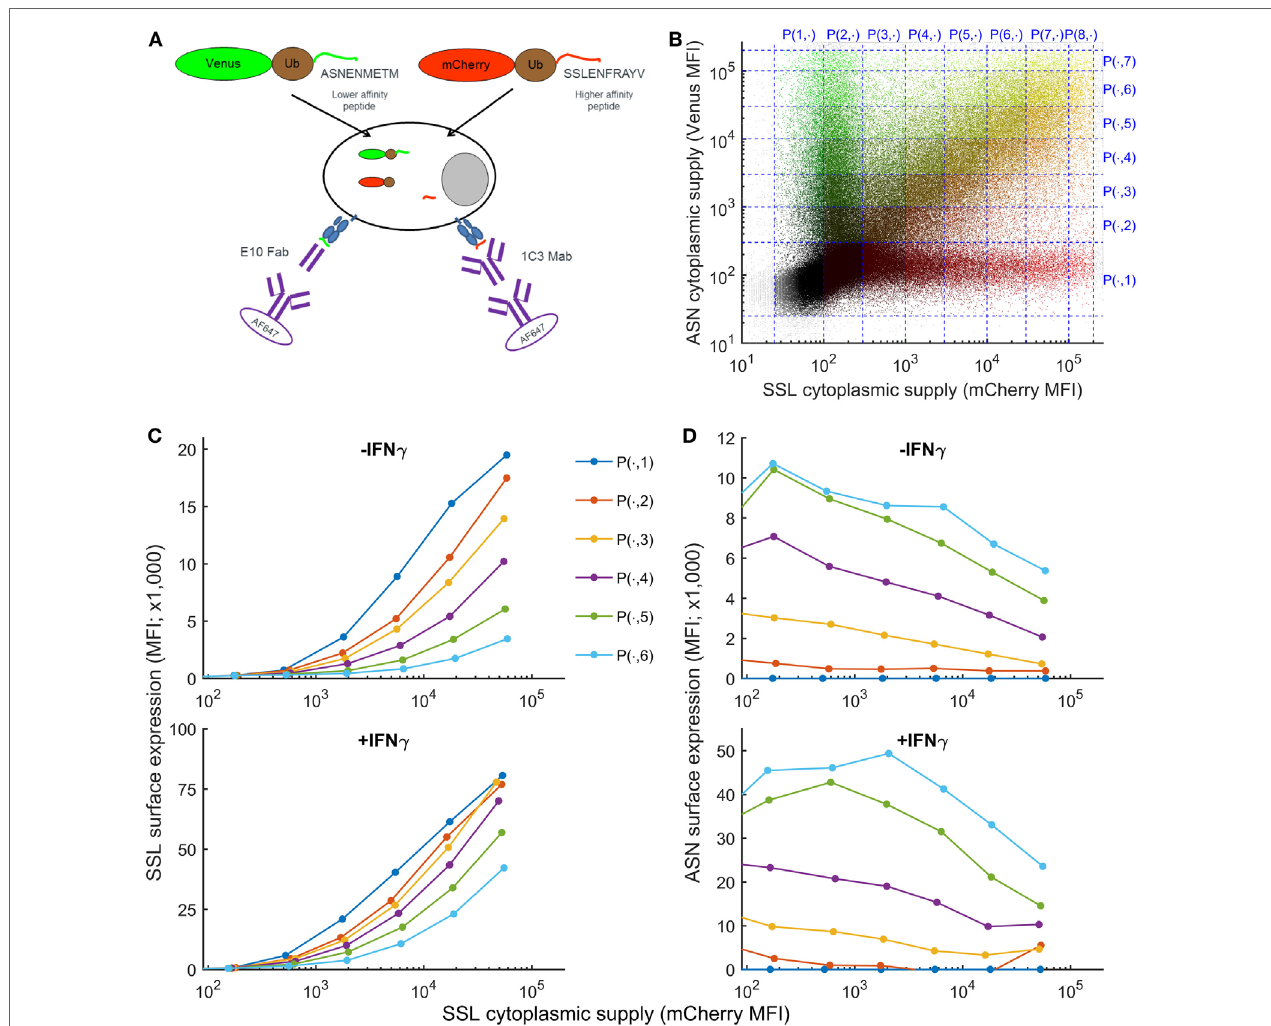
FigUre 1 | Simultaneous measurement of intracellular peptide abundance and cell surface peptide–MHC complex (pMHC). (a) Experimental setup. Fibroblasts were co-transfected with constructs expressing fusion proteins made of a fluorescent protein, ubiquitin, and a peptide. Cytoplasmic ubiquitin hydrolases cleave the fusion proteins, releasing an equimolar ratio of peptide and fluorescent protein. Peptides are transported to the endoplasmic reticulum where they can compete for loading onto MHC-I molecules. Then they migrate to the cell surface where ASNENMETM-H2Db complexes can be detected using E10 Fab and SSLENFRAYV- H2Db using the 1C3 chimeric Mab followed by a secondary antibody conjugated to AF647. (b) In a single transfection assay, cells were expressing low to high levels of both fusion proteins and were separated in different gates for the purpose of the analysis. (c) Level of SSLENFRAYV-H2Db surface expression in the presence of increasing amount of competitor. The dark blue curve shows the maximum surface expression as the cytoplasmic level of SSLENFRAYV peptide, represented on the x -axis, increases. The other curves represent the SSLENFRAYV-H2Db surface expression in the presence of different levels of ASNENMETM competitor [top dark blue curve corresponds to gates P(1, 1) to P(8, 1) with no competitor, down to the light blue bottom curve corresponding to gates P(1, 8) to P(8, 8) with the maximum level of competitor] in untreated wild-type cells (top panel) or in IFN γ -treated cells (bottom panel). (D) Corresponding ASNENMETM-H2Db surface